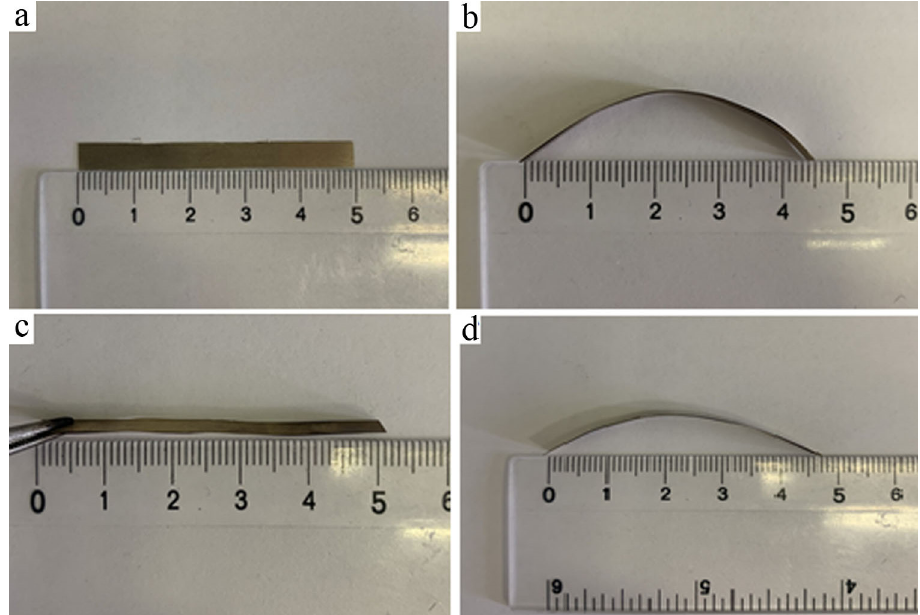
Figure 10. Photos of the demonstration of SME in a hardened Cu-14Al-3Ni alloy subjected to ( a ) cooling in liquid nitrogen, ( b ) bending, ( c ) heating to room temperature and ( d ) cooling in liquid nitrogen with the realization of reversible SME.